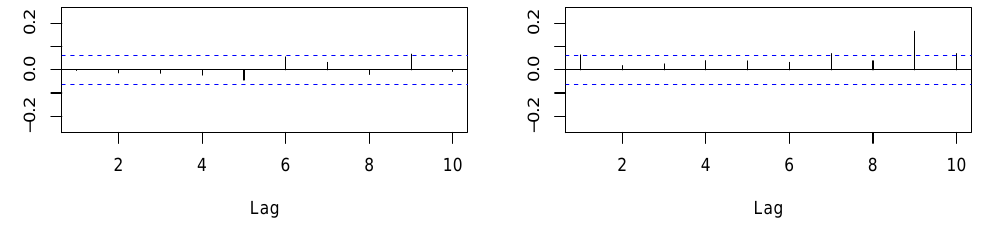
Figure 7. (cid:98) w t , in-sample autocorrelations of AR(5) residuals ( left ) and their squares ( right ).